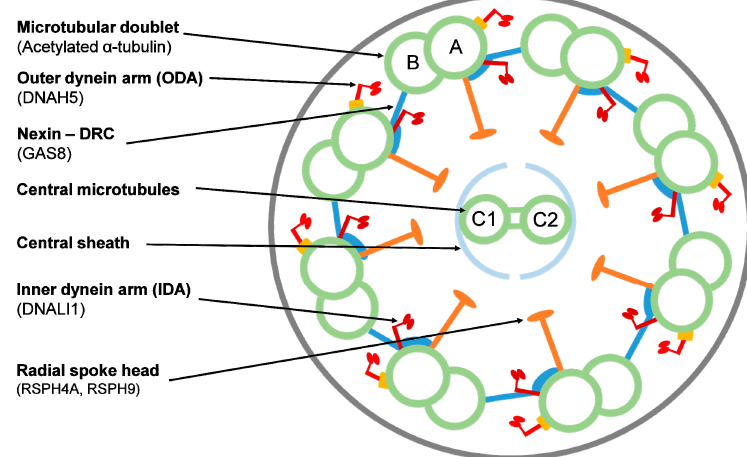
Figure 1. Ciliary axoneme in transverse section indicating the ultrastructural parts and the target proteins by immunofluorescence. Proteins are indicated in parentheses. DRC = dynein regulatory complex. A and B: outer microtubule doublets; C1 and C2: central pair.